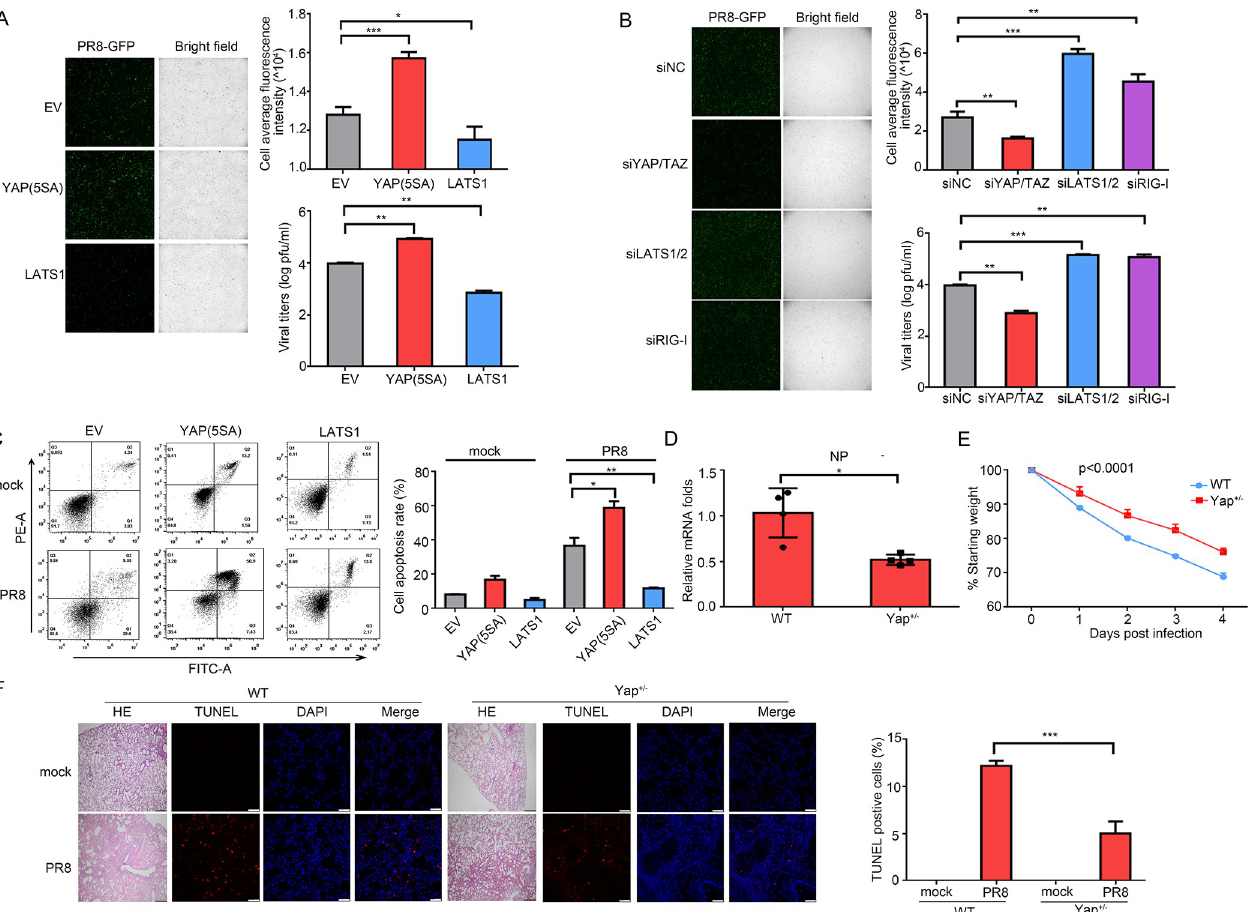
Fig 3. YAP/TAZ antagonize host antiviral defense against IAV in vitro and in vivo . (A, B) A549 cells either stably overexpressing EV, YAP(5SA) and LATS1 (A), or transfected with siNC, siYAP/TAZ, siLATS1/2 and siRIG-I (B) were infected with PR8-GFP at an MOI of 0.005. After 24 hours, GFP fluorescence was detected (left panel). Cell average fluorescence intensity per cell was calculated (upper right panel). The viral titers in the culture supernatants were measured using a plaque assay (lower right panel). (C) Cells overexpressing EV, YAP(5SA) and LATS1 respectively were infected with PR8 virus at an MOI of 0.02 for 24 hours. The apoptotic rate was analyzed by Annexin V-propidium iodide double staining. Representative plots of propidium iodide versus Annexin V-FITC fluorescence signals (left), and percentage of apoptotic cells (right) are shown. (D) WT and Yap +/- mice (n = 4 per group) were infected intranasally with 10 3 PFU of PR8, and lungs were harvested for NP mRNA quantification by RT-qPCR. (E) Body weight loss (%) of WT and Yap +/- mice (n = 5 per group) after PR8 infection was measured. (F) Yap+/- and WT mice infected with PR8 and corresponding mock controls. The lung sections collected 2 days post infection were stained with haematoxylin and eosin. Scale bar: 200 μ m. The apoptotic cells were showed by TUNEL staining with DAPI for cell nuclei (left panel). Scale bar: 40 μ m. The percentage of TUNEL-positive cells was calculated (right panel). Data in (A-C) were repeated at least three times. Data in (A-F) are presented as means ± SD. � p < 0.05, �� p < 0.01, ��� p <